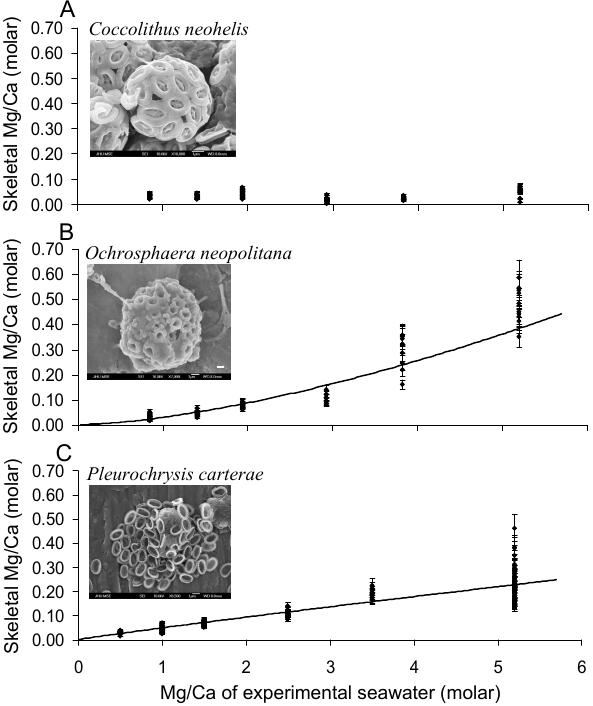
Fig. 16. Mg/Ca ratio of calcite secreted by coccolithophore species Coccolithus neohelis (A) , Ochrosphaera neopolitana (B) , and Pleu- rochrysis carterae (C) as a function of the Mg/Ca ratio of the ex- perimental seawater in which they were reared. Error bars represent standard error of microprobe analysis. Fitted curves are power func- tions fit to the data using least squares regressions. From Stanley et al.